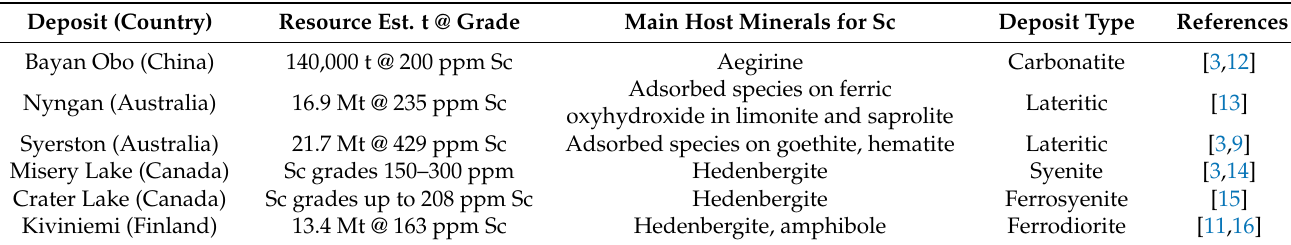
Table 1. General features of selected Sc